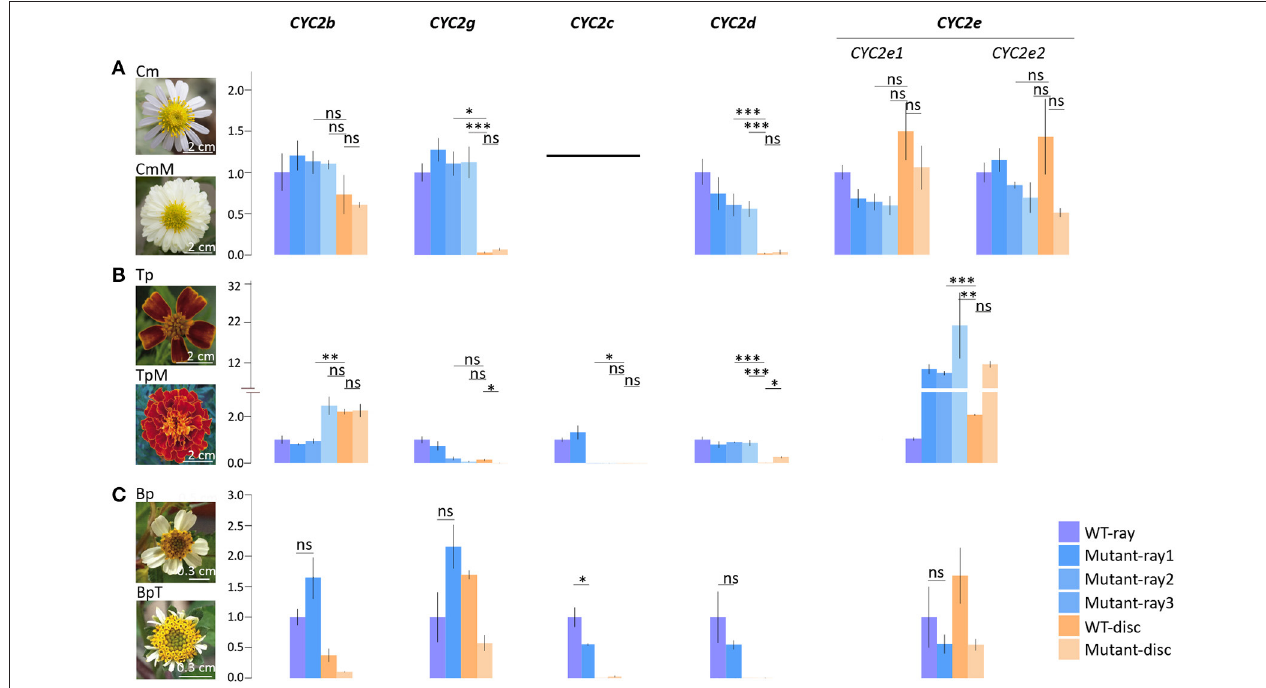
FIGURE 4 | Comparative expression analysis of the Asteraceae CYC2 -like genes in different types of capitulum. (A) Comparison between the wild type Chrysanthemum morifolium (Cm) and its multiradiata cultivar (CmM). (B) Comparison between the wild type Tagetes patula (Tp) and its multiradiata cultivar (TpM). (C) Comparison between the wild type Bidens pilosa (Bp) and its natural trans-ray mutant (BpT). Expression levels of ACTIN7 were used for normalization; expression levels of each CYC2 copy in the cultivar were normalized against its expression in the ray florets of the wild type via the 2 − 11 C T method (Livak and Schmittgen, 2001 ). Error bar is s.e. value of three biological samples. The two-tailed t- test was used for statistical tests: * P ±